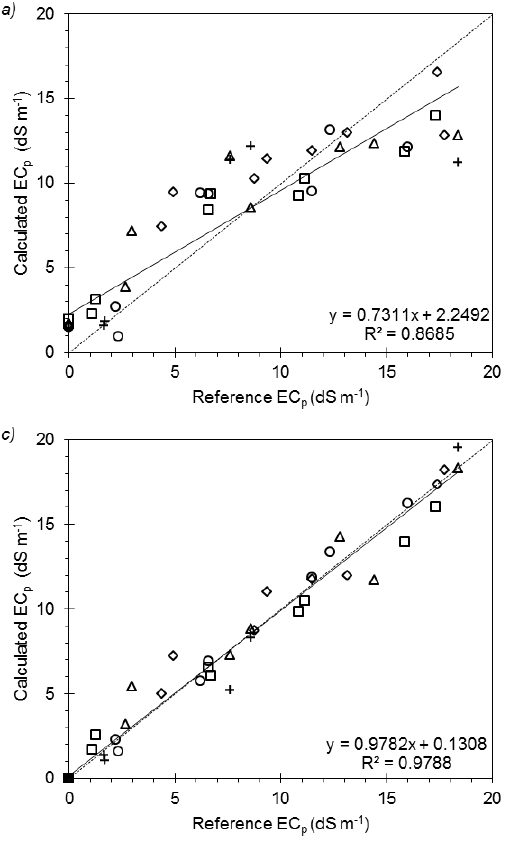
Figure 4. Comparison of calculated vs. reference pore-water electrical conductivity for the five soil samples using the ―general‖ ( a ) Malicki and Walczak, ( b ) Hilhorst, ( c ) Rhoades, and ( d ) Archie models.; The symbols refer to: □ site A, topsoil; ◊ site A, subsoil; ○ site B, topsoil;  site B, subsoil; and ∆ site C,